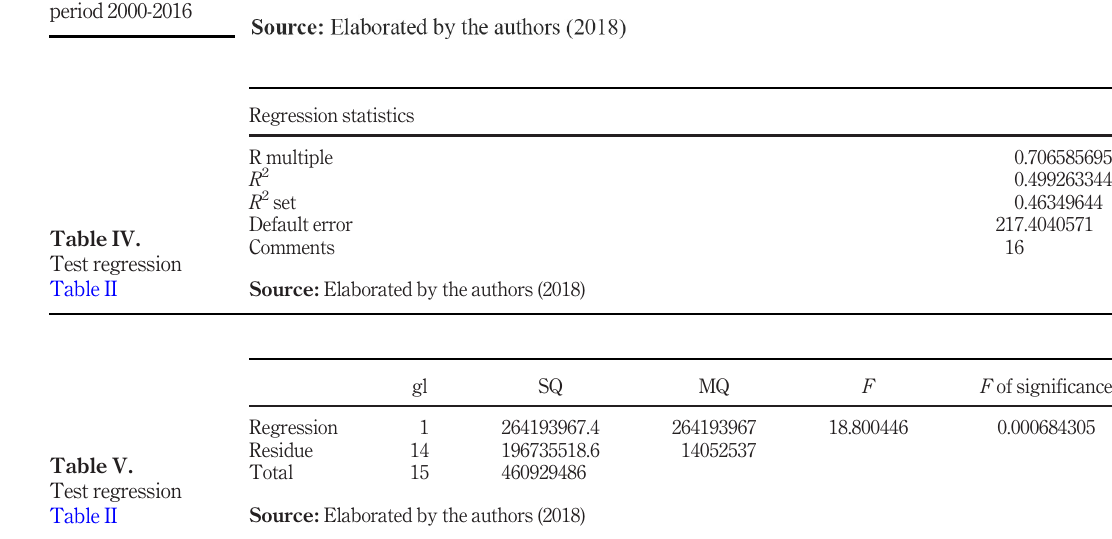
Figure 3. Regression of the fi rst period 2000-2016